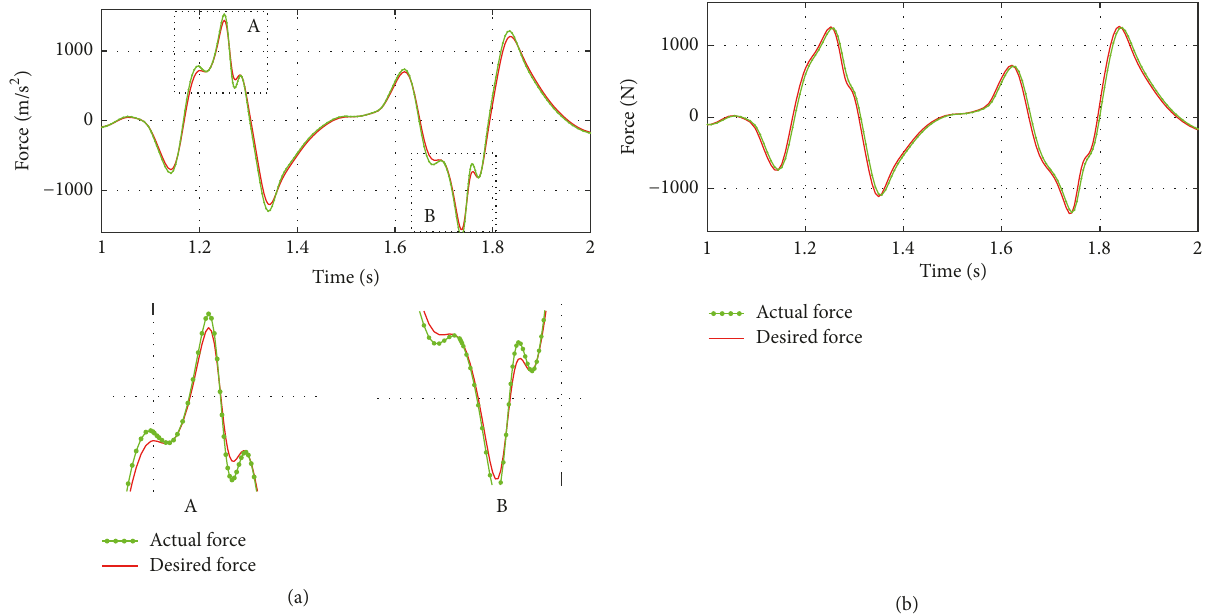
Figure 6: Tracking performance of the inner loop control: (a) T-S fuzzy based Backstepping control; (b) T-S fuzzy based ARC